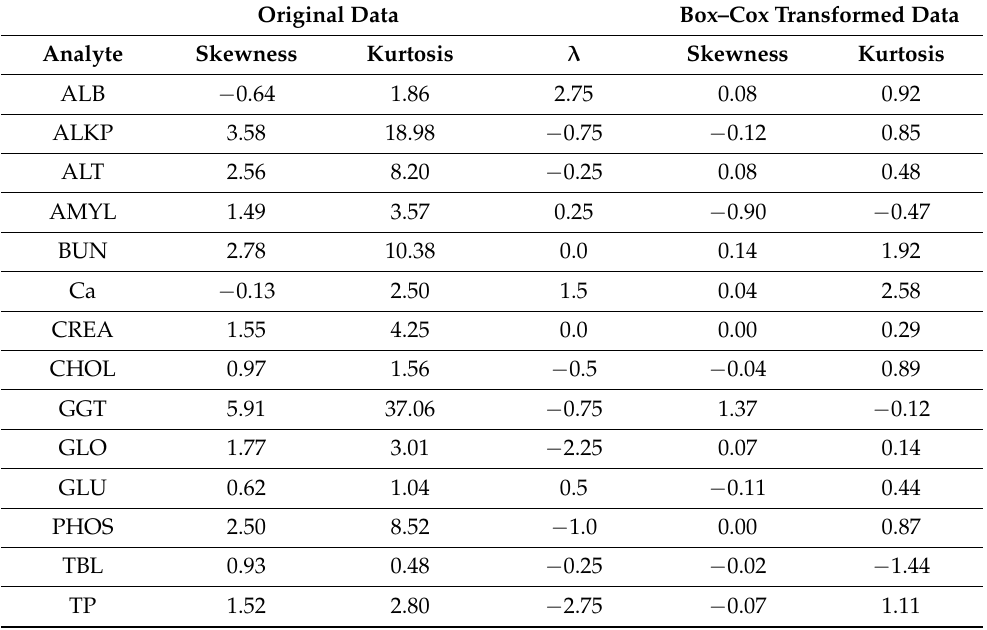
Table 2. Skewness and kurtosis of the original and Box–Cox transformed data and the Box–Cox power parameters ( λ ). Original Data Box–Cox Transformed